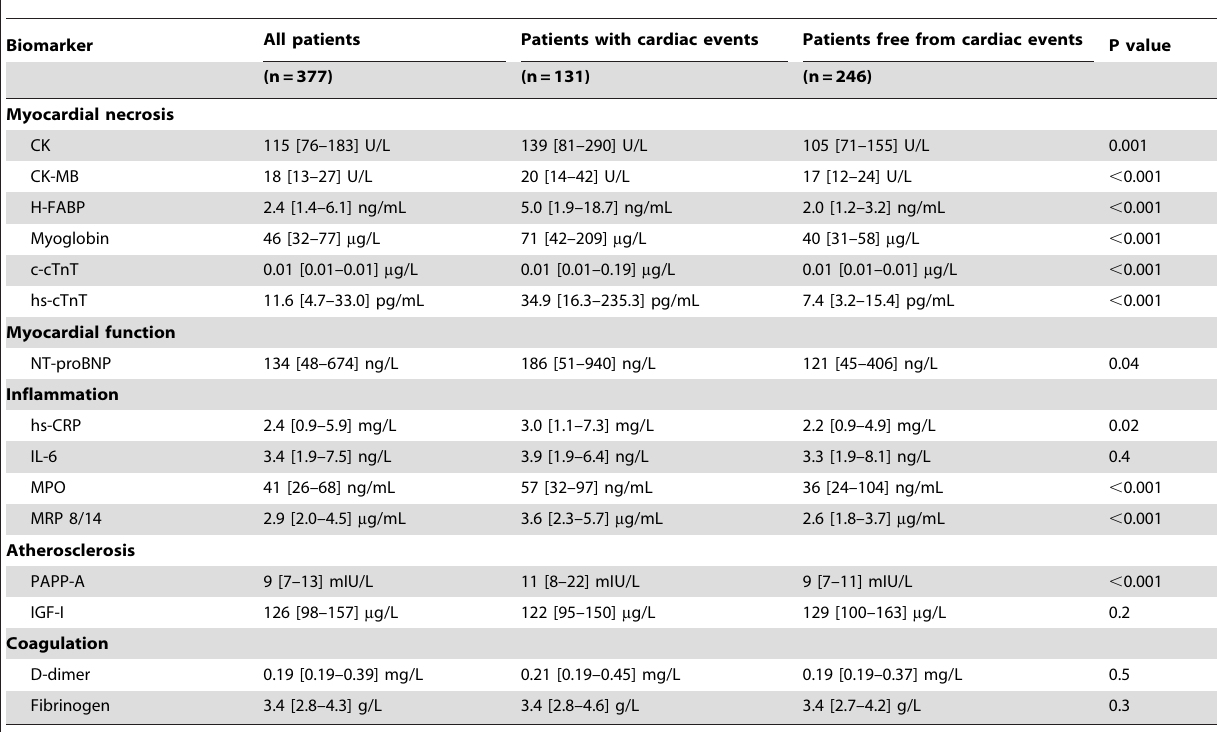
Table 3. Biomarker levels in patients with and without cardiac events